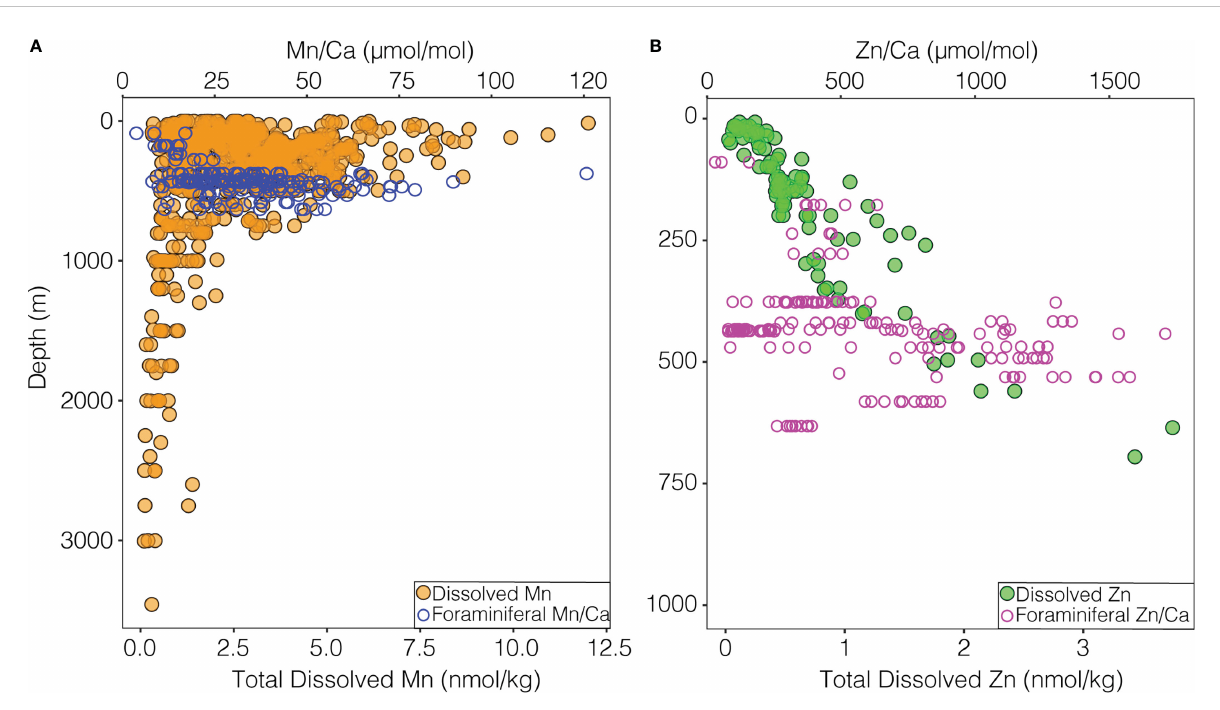
FIGURE 5 (A) Dissolved Mn with depth in the ETNP (solid orange points) from Moffett (2020) and John et al. (2022). Individual foraminiferal shell Mn/Ca (open blue points) at the mean depth from the net in which they were collected. (B) Dissolved Zn with depth in the ETNP (solid green points) from John and Moffett (2021). Individual foraminiferal shell Zn/Ca (open pink points) at the mean depth from the net in which they were